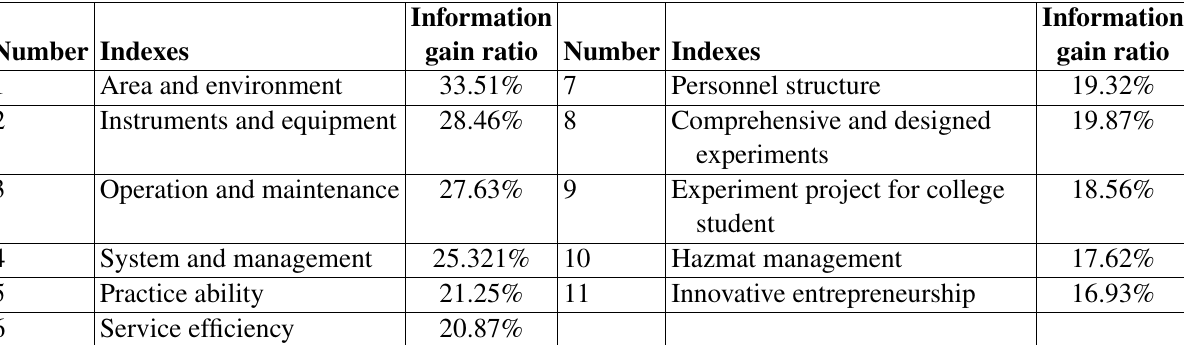
Table 5 Laboratory evaluation index